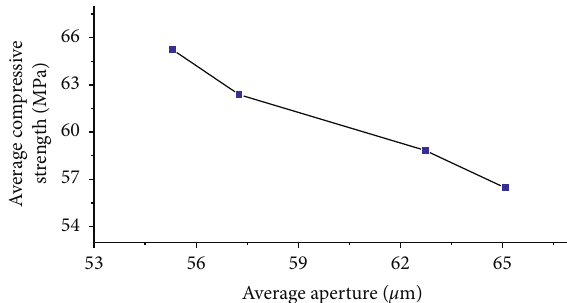
Figure 17: Average compressive strength and average aperture